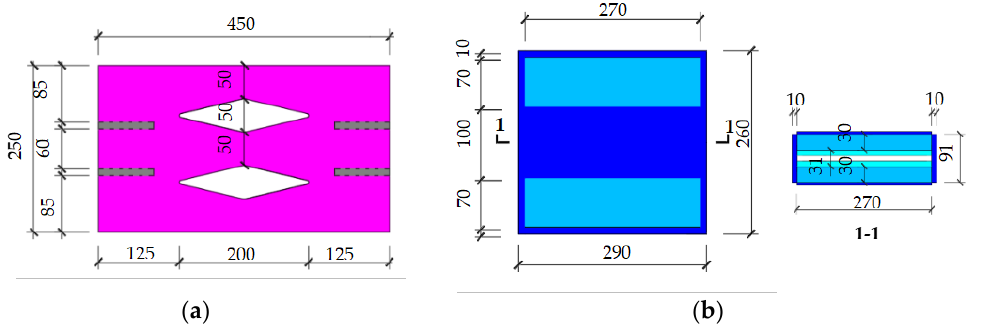
Figure 3. ( a ) Front view of the energy-dissipating steel hinge; ( b ) front view of the web mechanical hinge (unit: mm).